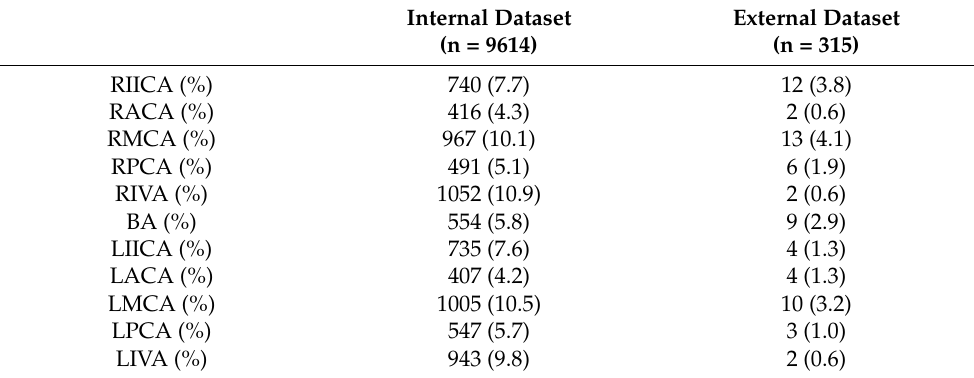
Table 1. The percentage of cases with confirmed stenosis ( ≥ 50% diameter stenosis) for each artery in both internal and external